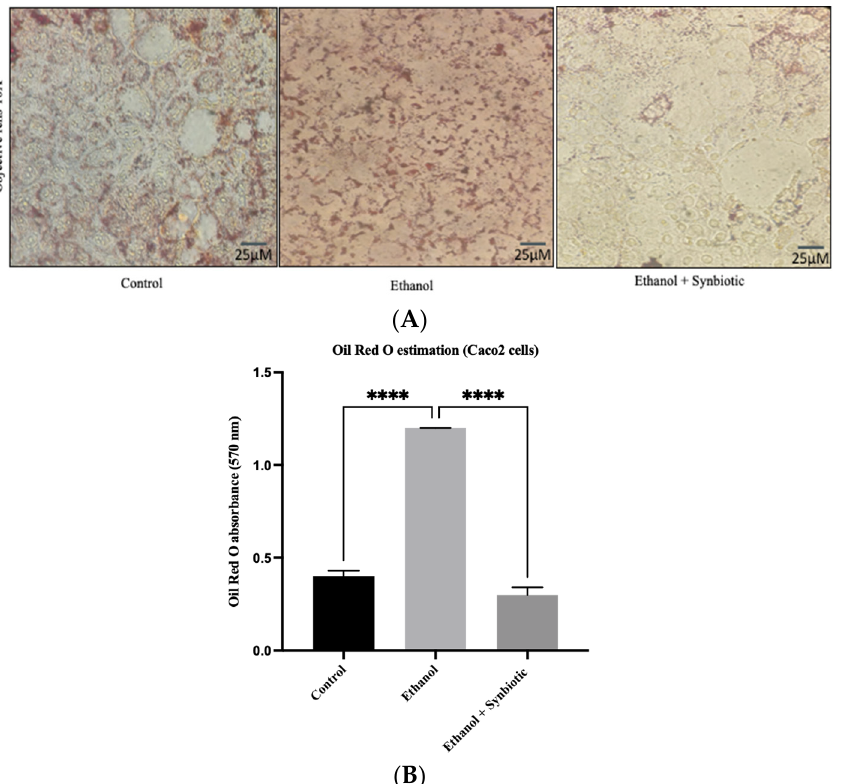
Figure 14. ( A ) Oil Red O-stained Caco-2 cells. Compared to the control group, the accumulation of lipids in Caco-2 cells increased in the ethanol group but was reduced significantly by synbiotic treatment at 100X. ( B ) Graphical representation of the Oil red O absorbance. The statistical analysis was calculated as mentioned in Section 2.10, **** p < 0.0001.